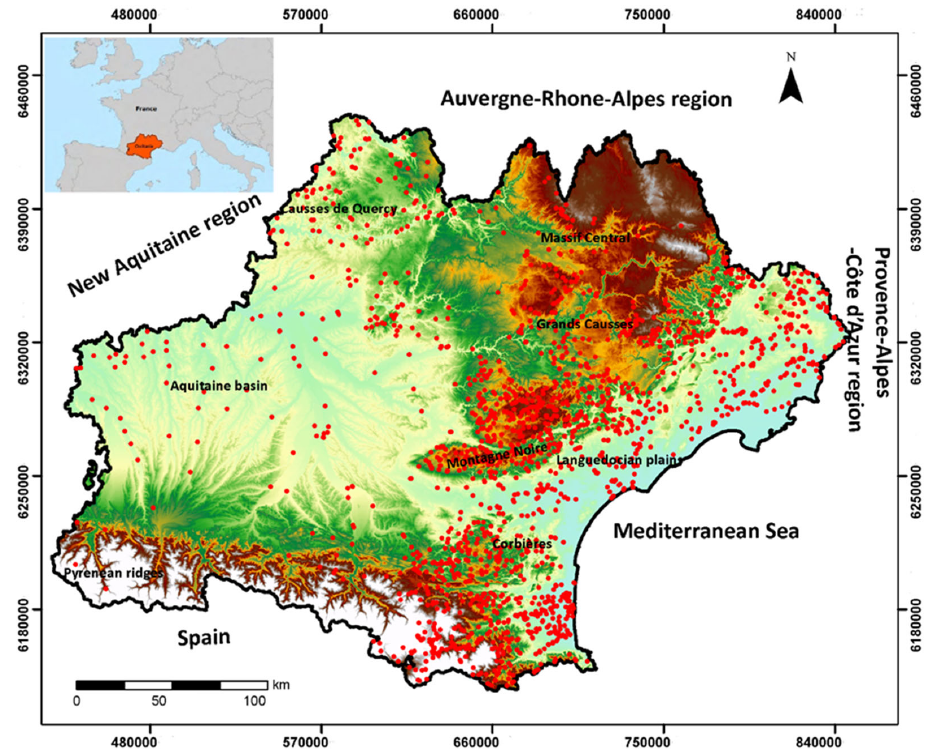
Figure 1. Location of the Occitanie region in southern France. Elevation and groundwater sampling points and major subregions.